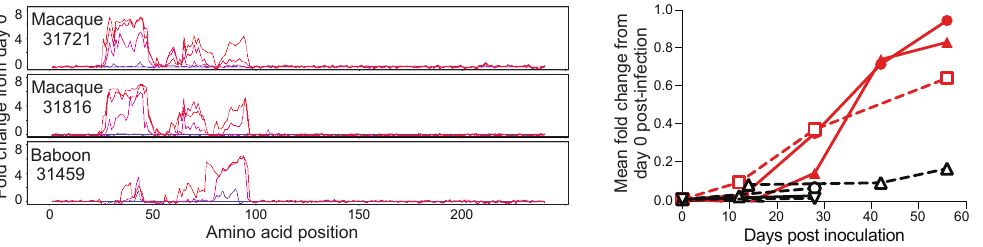
Figure 5. Peptide array analysis of antibodies generated by baboons and macaques inoculated with SWBV. A custom-designed array of 16-mer peptides spanning each of the SWBV proteins predicted from the SWBV inoculum nucleotide sequence was constructed and plasma from SWBV-infected animals was overlaid on this array to identify SWBV-specific antibodies. (A) Intensity of antibodies binding to peptides corresponding to the envelope glycoproteins of SWBV, normalized to the day zero post-inoculation intensity for each peptide from each animal, with day zero shown in blue and subsequent days shown in increasing shades of red. Note, numbers on the X-axis correspond to the first amino acid in the 16-mer peptide. (B) Normalized intensities over time from the GP5 protein of the three animals that became infected with SWBV; the graph to the right shows the mean fold change from day zero post-inoculation for all GP5 peptides, with SWBV-infected animals shown in red.